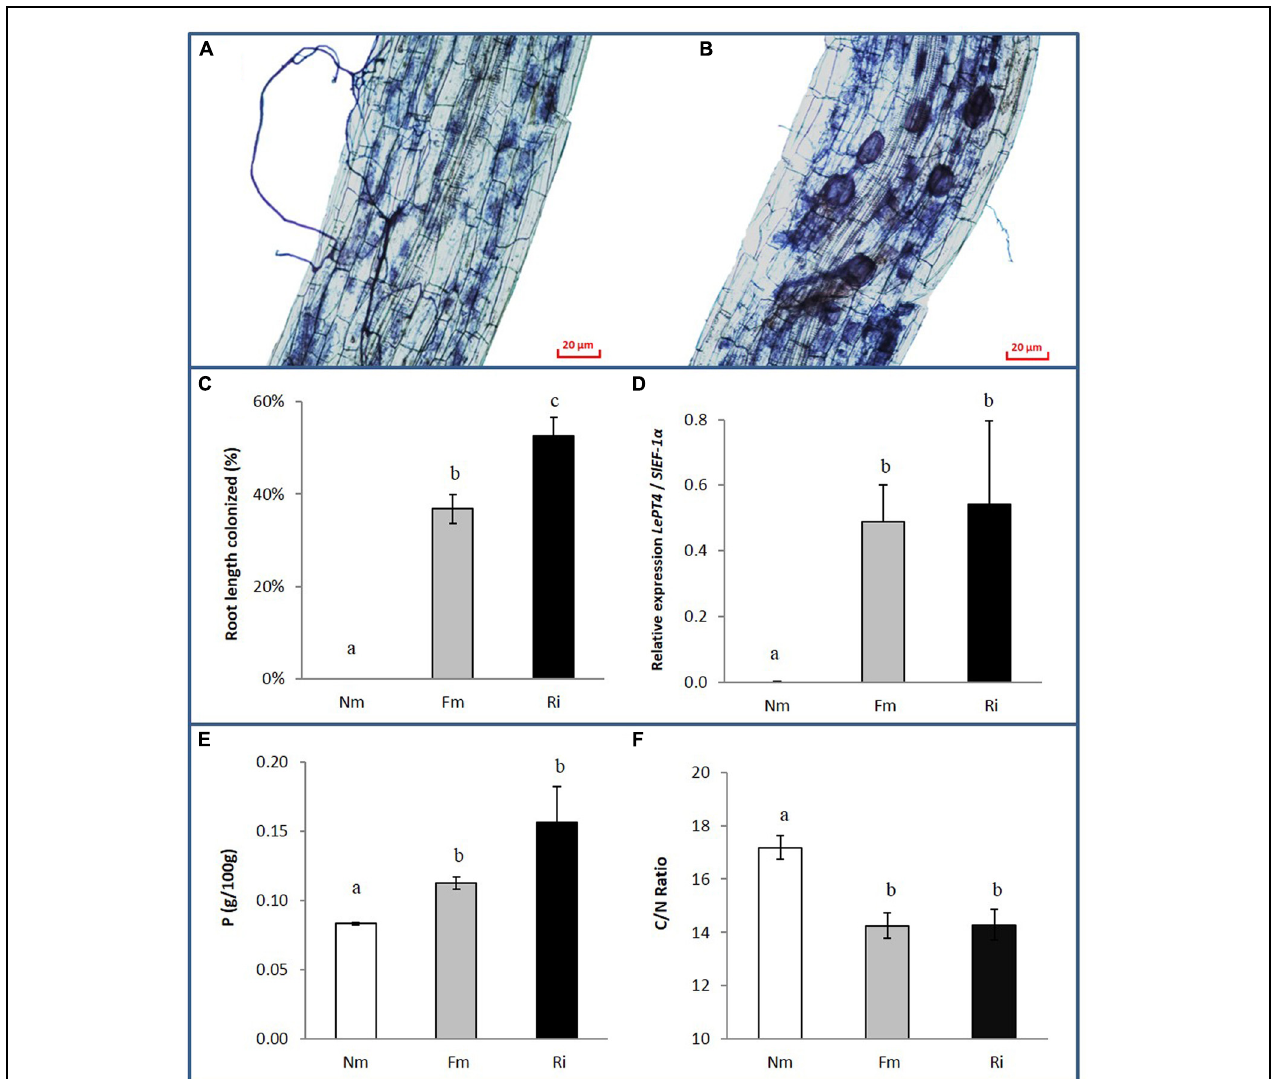
FIGURE 1 | Fungal colonization and nutrient content in non-mycorrhizal (Nm) and mycorrhizal tomato roots colonized by either Funneliformis mosseae (Fm) or Rhizophagus irregularis (Ri), 8 weeks after inoculation. (A) Ink-staining of fungal structures in Fm and (B) Ri colonized roots. (C) Percentage of root length colonized by the mycorrhizal fungi. Data represent the means of 10 independent biological replicates ± SE. (D) Expression levels of